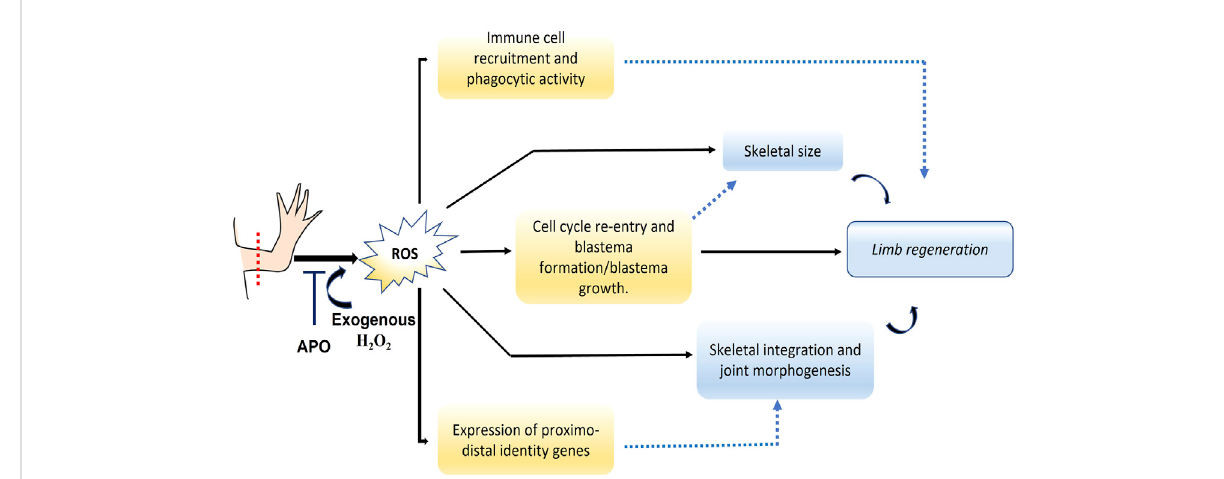
FIGURE 10 Graphical abstract of the results obtained and putative mechanistic insight of ROS in regeneration. Following limb amputation, ROS are produced. The production of ROS is necessary for the re-entry into the cell cycle of the remaining tissues and consequently for the formation and growth of the blastema. ROS also regulates the expression of genes previously involved in blastema formation such as Yap1 and Agr2 . This suggests that ROS production-dependent blastema size in fl uences the fi nal size of the limb and its regenerating skeleton. Moreover, ROS regulates the expression of proximal-distal identity genes, suggesting that the obtained phenotype of integration failure between the regenerated and remnant skeleton as well as alterations in joint morphogenesis could be regulated by ROS production. In addition, ROS are necessary to promote the recruitment of in fl ammatory cells such as leukocytes including monocytes/macrophages during blastema formation, as well as their phagocytic activity. Therefore, we hypothesize that the regulation of the in fl ammatory response represents a potential mechanism by which ROS mediate its function during axolotl limb regenearation. The solid black lines represent the results obtained in this work and the dotted blue lines represent the proposed relationships according to previous studies and those obtained in this